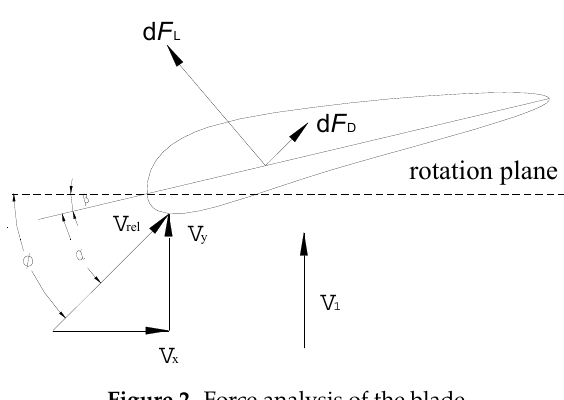
Figure 2. Force analysis of the blade.